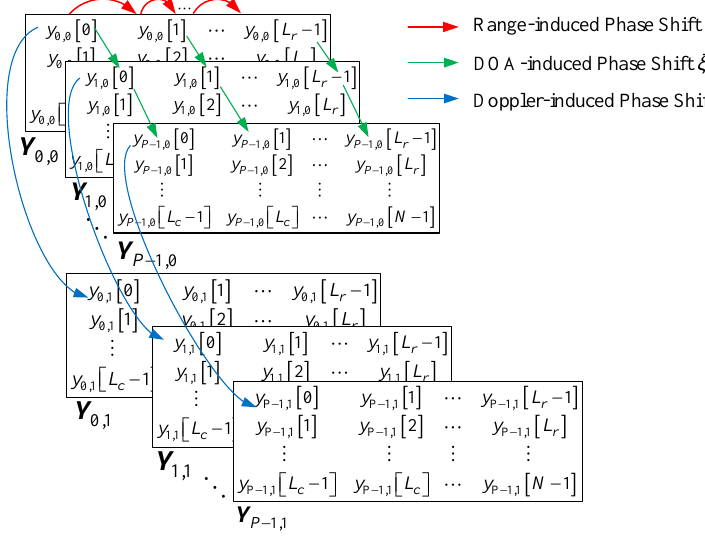
Figure 4. 3D Shift Invariant Structure.